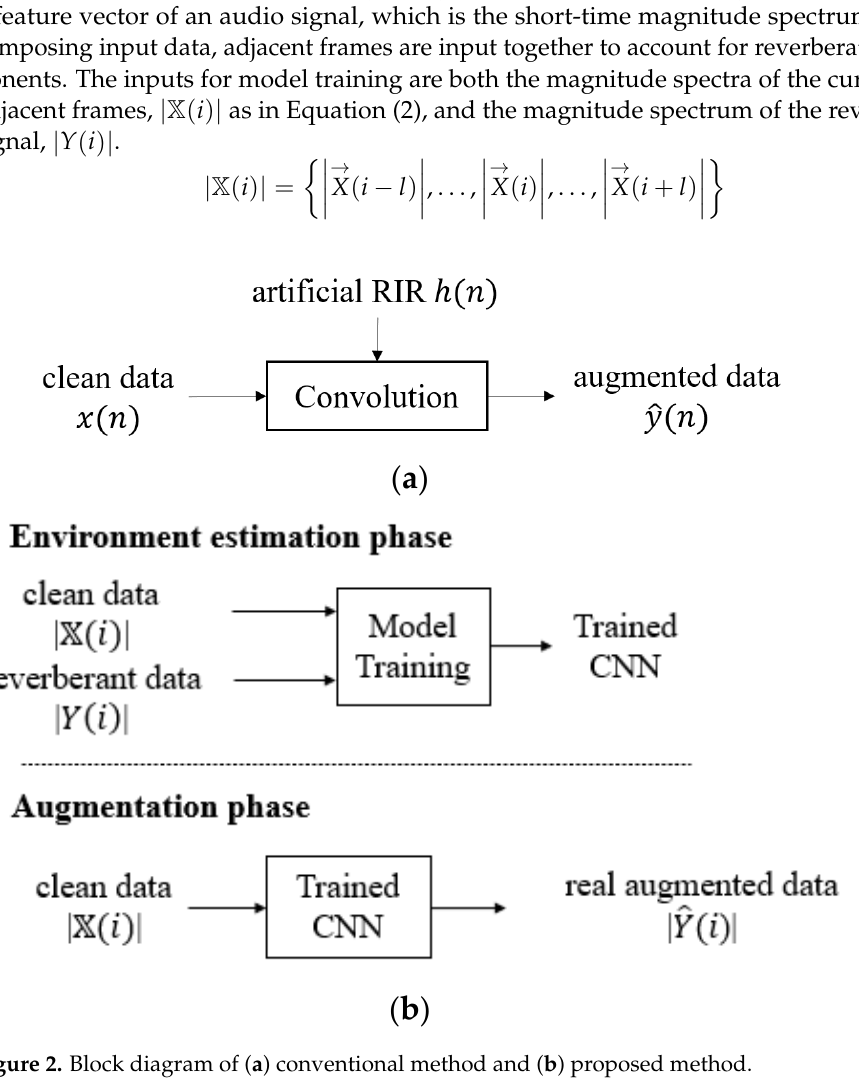
Figure 2. Block diagram of ( a ) conventional method and ( b ) proposed method. As well, the phase of the clean